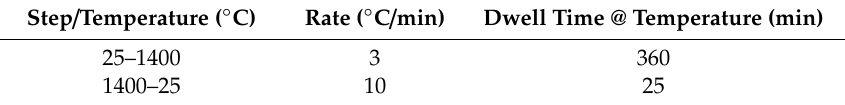
Table 3. Sinter program.